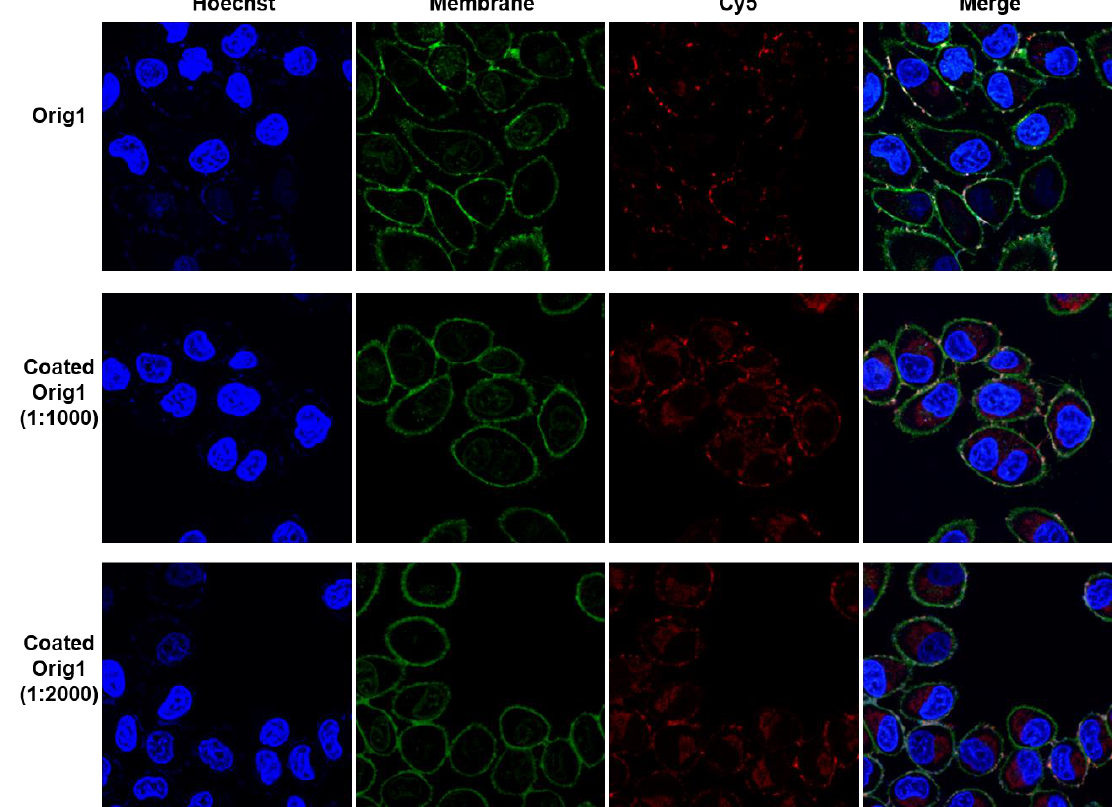
Figure 4. Confocal images of Hela cells incubated with plain Orig1 and coated Orig1 with ratio of 1000 and 2000.